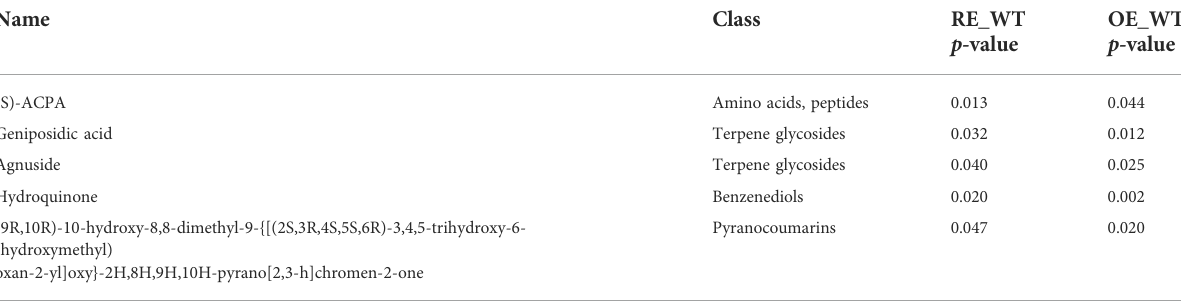
TABLE 2 5 differential metabolites between RE vs. WT and OE vs.